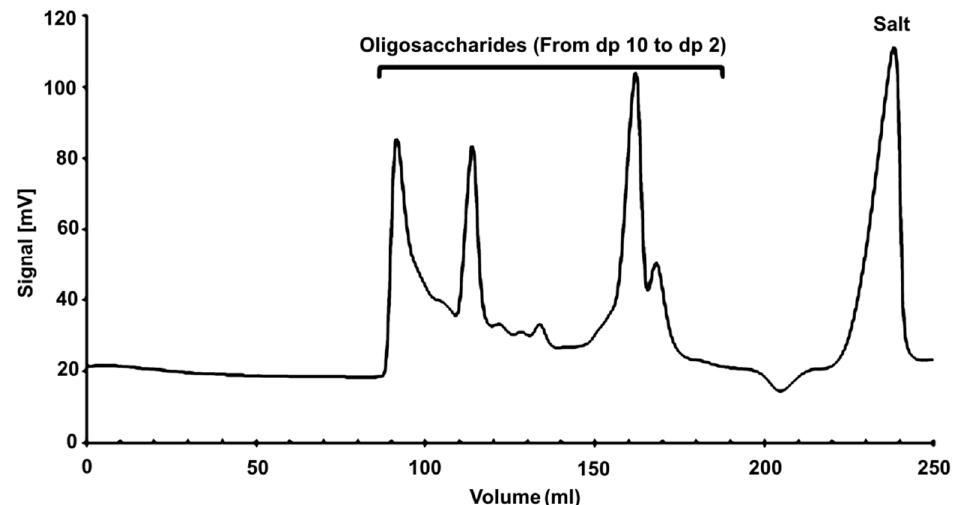
Figure 3. Biogel P2 chromatogram of P. major low molecular fraction (PLM).